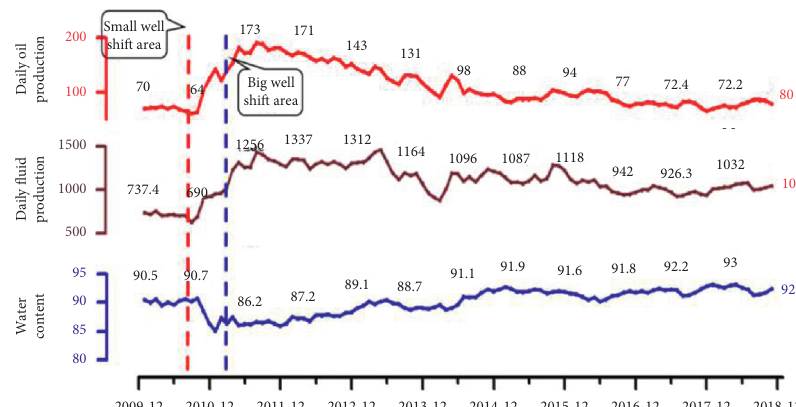
Figure 8: Oil production curve for thermochemical combination flooding of the test well group in the Gudao Oilfield.